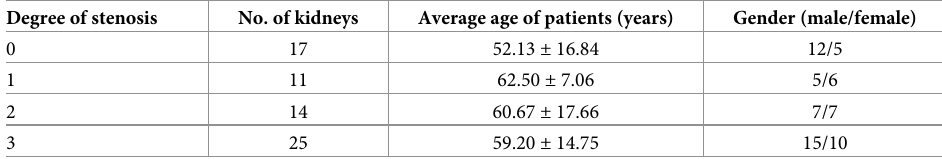
Table 1. Subgroups of patients with different degrees of renal artery stenosis.